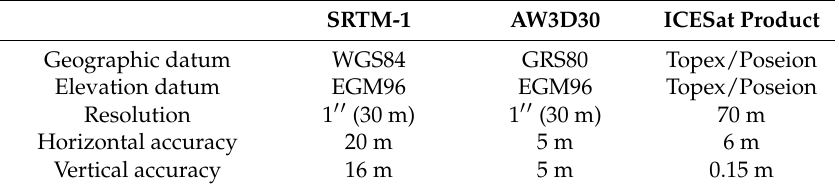
Table 1. The basic parameters of the the 1-arc-second Shuttle Radar Topography Mission Global digital surface model (AW3D30 DSM), and the Ice Cloud and Land Elevation Satellite (ICESat) global land surface altimetry